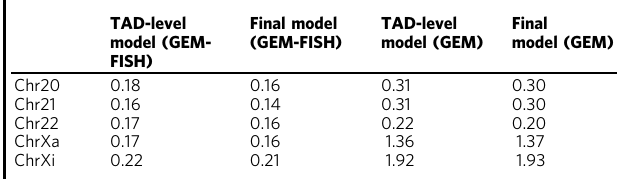
Table 1 The average relative errors of the TAD-level resolution and fi nal models reconstructed by GEM-FISH using both Hi-C and FISH data, and by GEM using Hi-C data only for Chrs 20, 21, 22, Xa, and